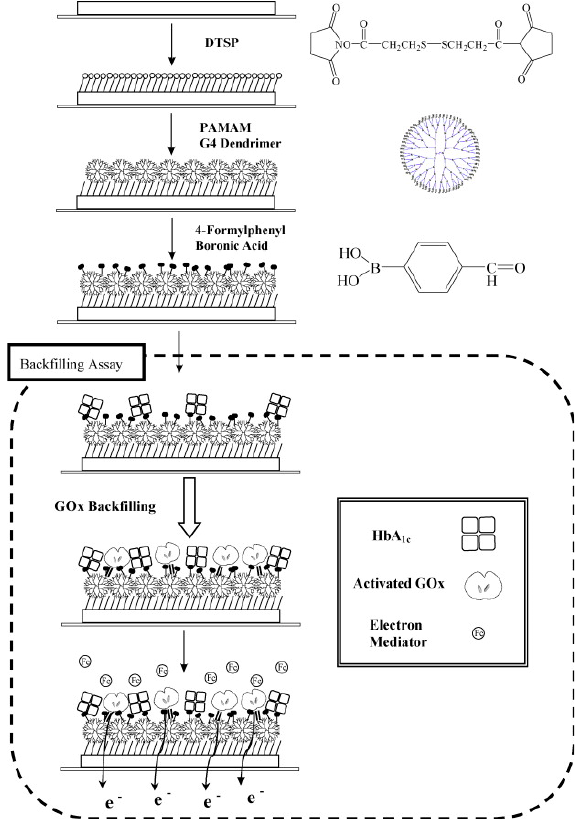
Figure 3. Scheme representing the backfilling assay − mediated amperometric detection of HbA1c employing boronic acid derivatives. Reprinted with permission from [37].